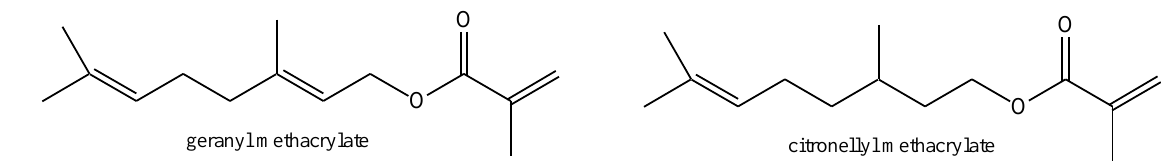
Scheme 1. Chemical formulae of terpene methacrylate monomers.